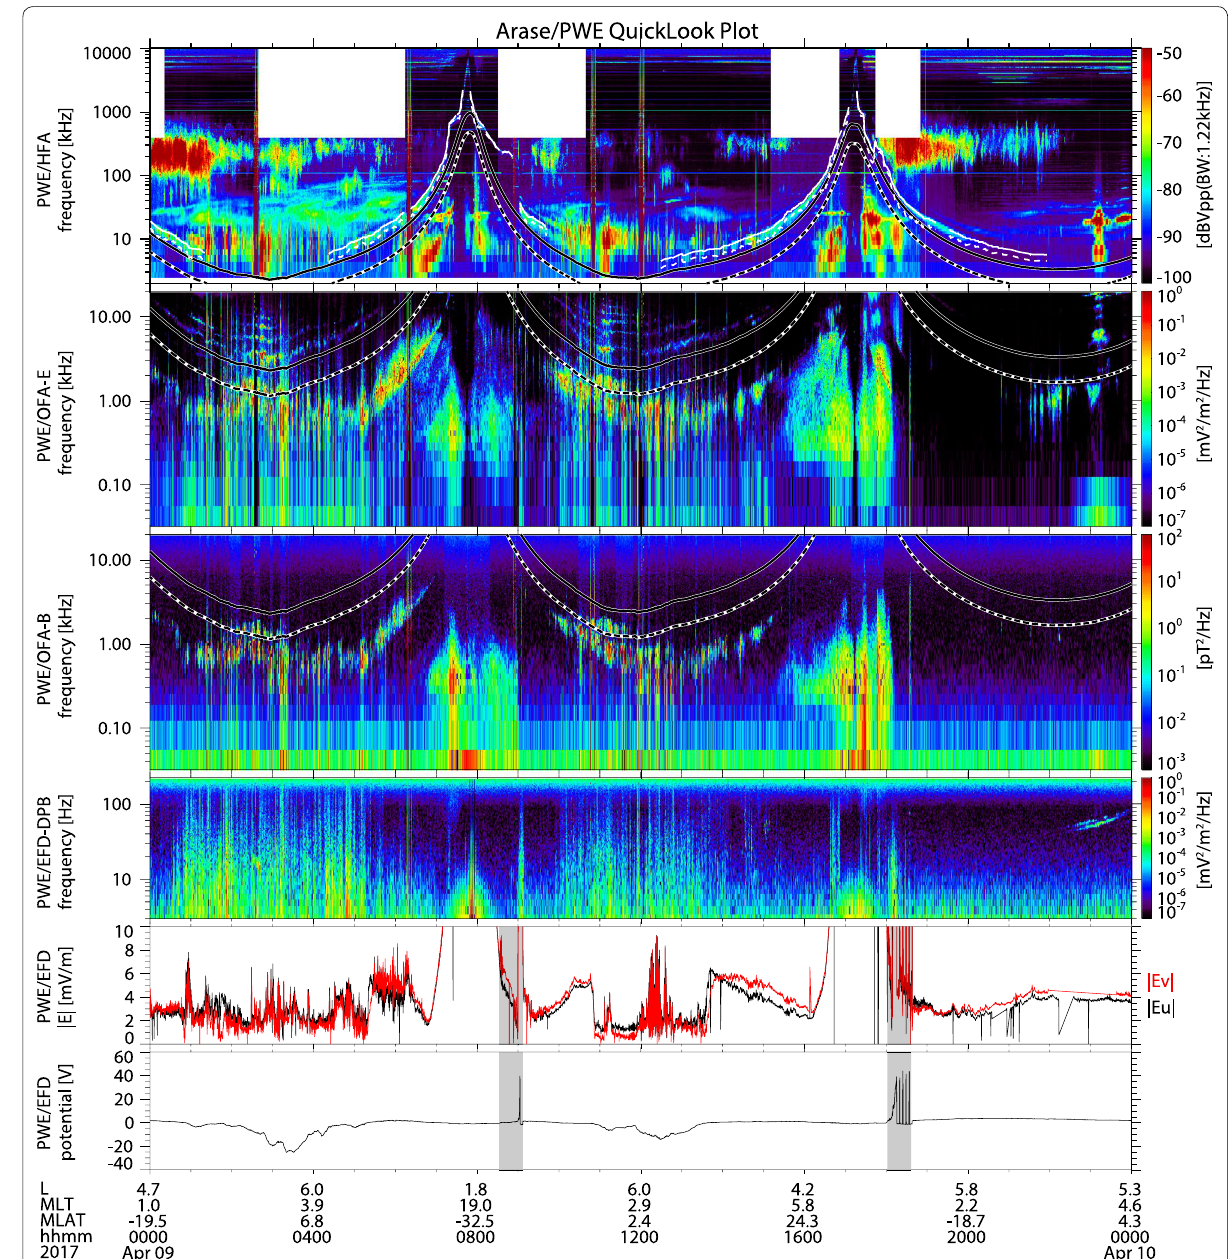
Fig. 10 PWE data on April 9, 2017, corresponding to the duration of Fig. 6 of Miyoshi et al. (2017). From the top, HFA spectrum (10 kHz to 10 MHz) (dt: 1 s), OFA-E spectrum (30 Hz to 20 kHz) (dt: 1 s), OFA-B spectrum (30 Hz to 20 kHz) (dt: 1 s), EFD E v spectrum at 1–224 Hz (dt: 1 s), EFD | E u | (black) and | E v | (red) (dt: 8 s), and EFD spacecraft potential as the average of V u1 , V u2 , V v1 , and V v2 (dt: 8 s) are shown. All data are tentatively calibrated. | E u | and | E v | data include ( V spacecraft ) (background magnetic field). The gray-shaded area indicates eclipse. The solid and dashed black lines in the HFA × and OFA-E/B panels indicate the local electron cyclotron frequency ( f ce ) and its half (0.5 f ce ), respectively, as calculated from the DC magnetic field measurement by MGF. The solid and dashed white lines in the HFA panel indicate the UHR frequency ( f UHR ) identified from the spectrum and the electron plasma frequency ( f pe ) derived from the MGF data,